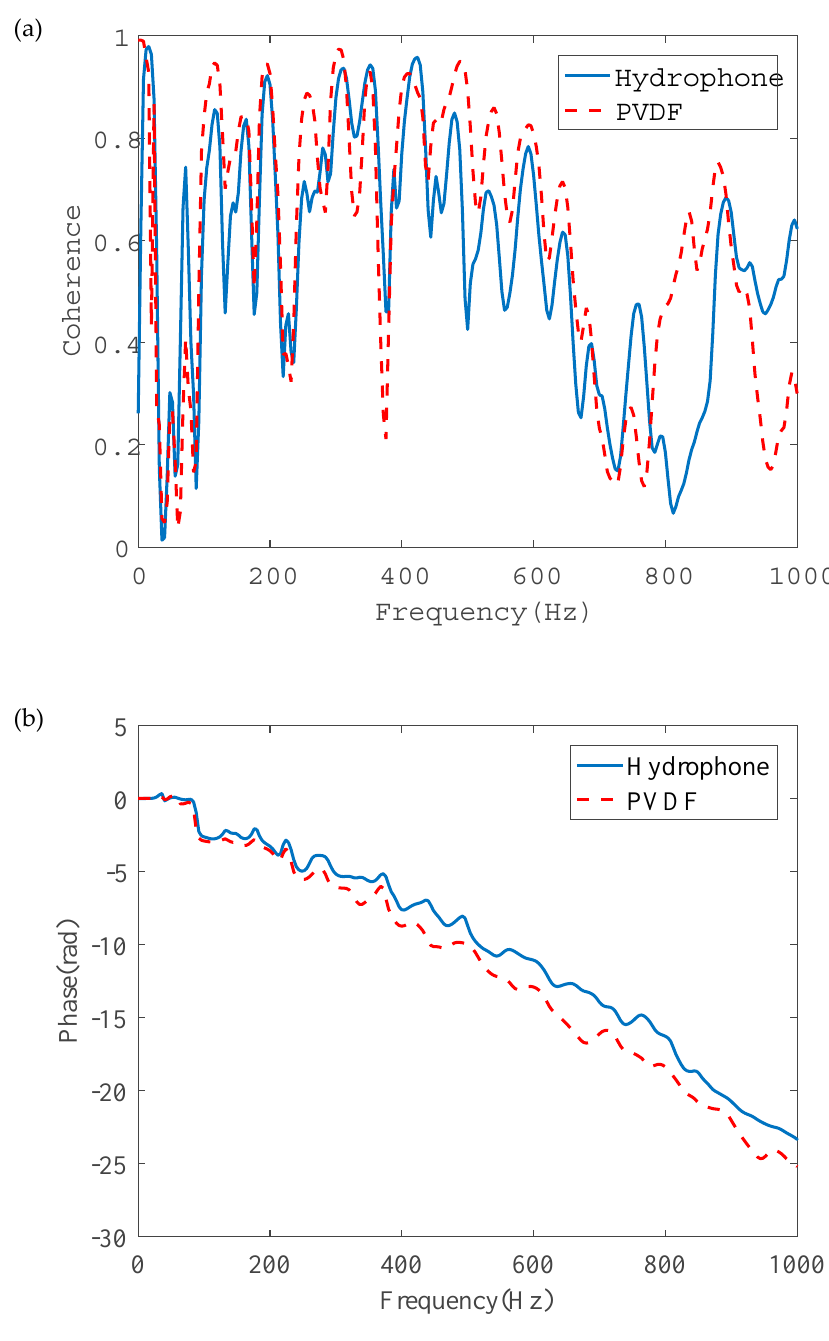
Figure 15. Frequency results of a pair of PVDF wire sensors and hydrophone pair at the distances of 0.1 m and 0.9 m (in-water case): ( a ) coherence; ( b ) phase spectrum.